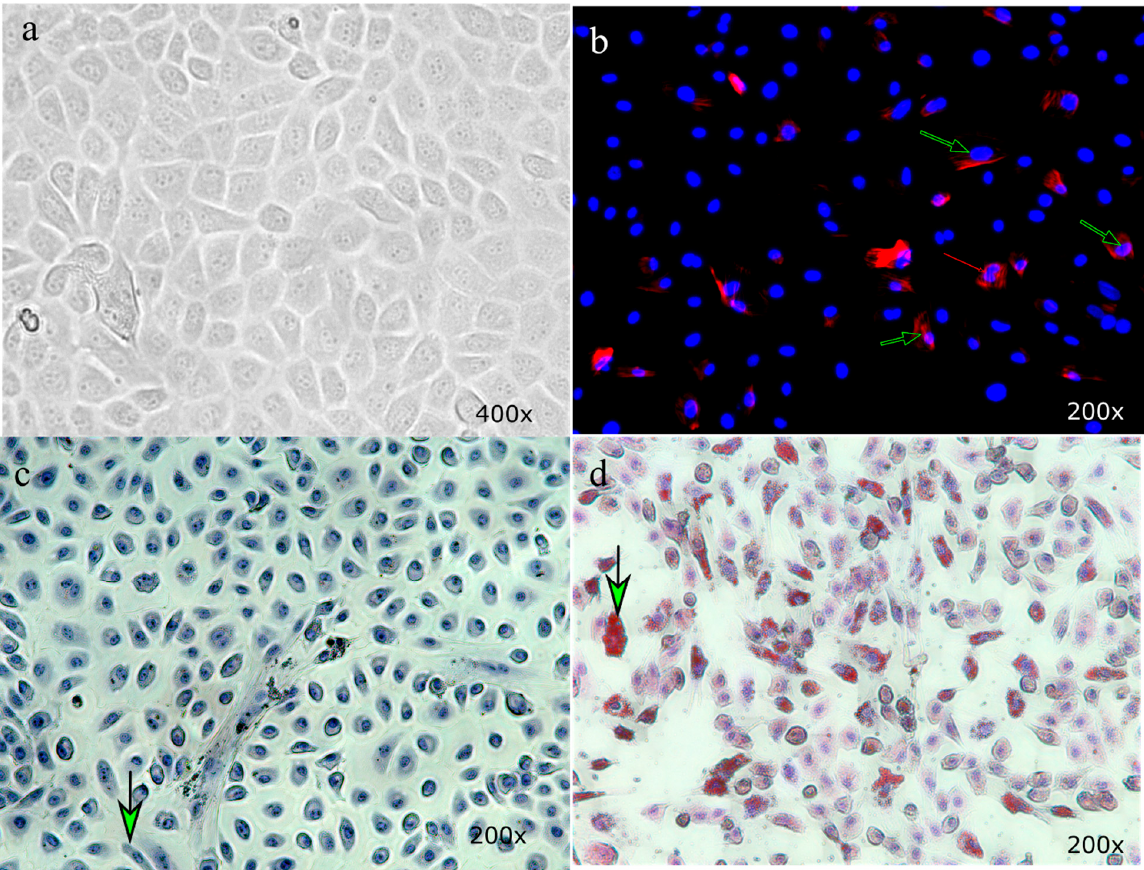
Figure 1. Treatment of bovine hepatic cells with TNFA and palmitate induced lipid accumulation. A representative image showing transillumination images of the majority of the cuboidal-shaped hepatocytes with a mixture of a few other cell types such as stellate cells ( a ). Stellate cells are fibroblast-like cells which are alpha-smooth muscle actin-positive ( b ). Induction of fatty liver disease by palmitate and TNFA, evaluated by lipid droplet staining using Oil Red O stain, showed no to very little storage of lipid droplets inside the cells ( c ) in comparison with heavy accumulation of lipid droplets in treatment of cells with a cocktail of palmitate and TNFA ( d ). Arrows in panel ( b – d ) indicate stellate